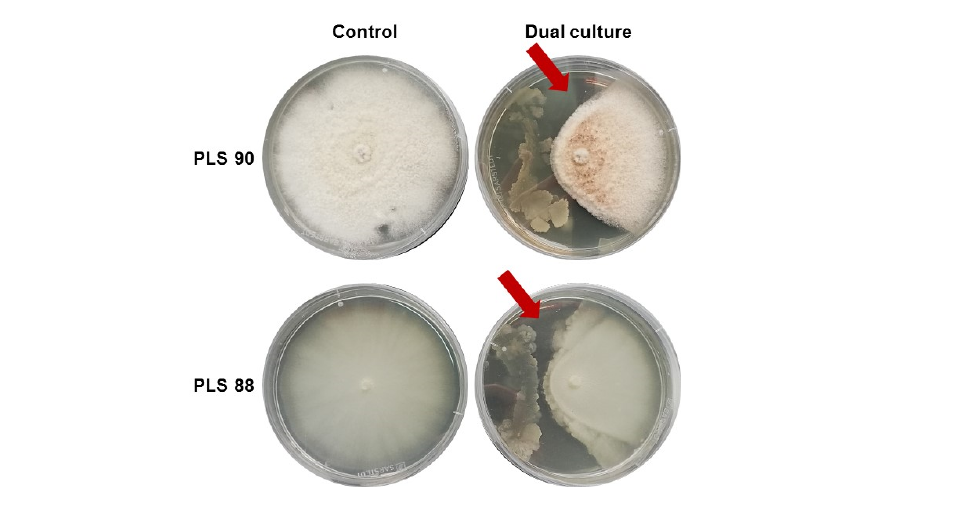
Figure 1. Confrontation bioassays for the bioactivity assessment of the olive tree bacterial isolate Bacillus sp. PTA13 against Colletotrichum acutatum species complex PLS 90 (wild type) and PLS 88 (resistant to PPPs) isolates. The formation of inhibition zone (red arrows) and the pattern of the fungal culture development were used as indicators of the bioactivity of the endophyte.